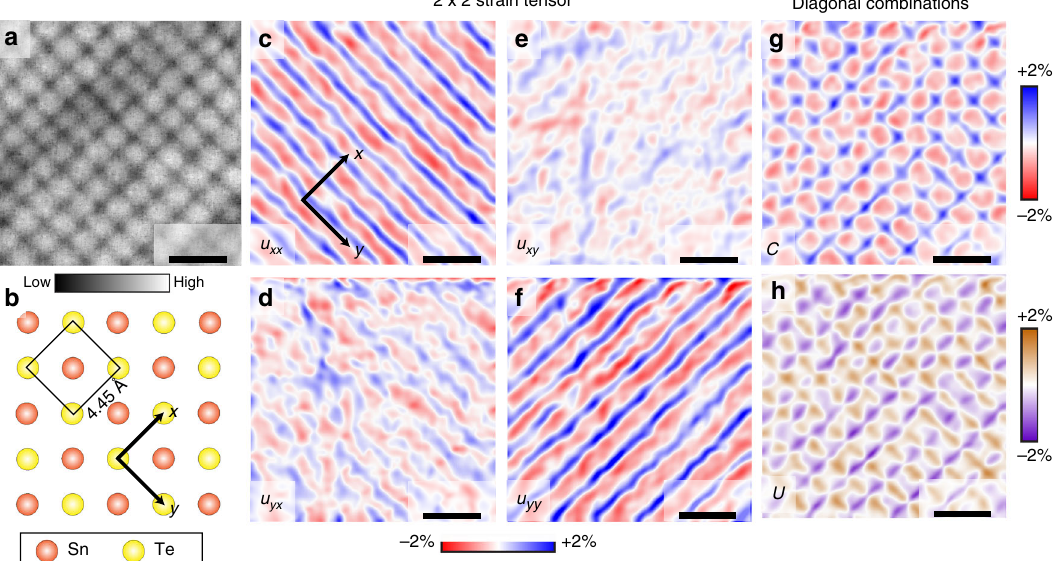
Fig. 2 Spatial distribution of different types of strain. a STM topograph of ~130 nm square region of the sample ( V set = − 50 mV, I set = 200 pA), showing the strain-generated topographic superlattice with period of ~ 15 nm. b Schematic of the (001) surface of SnTe. Arrows in b denote the x - and y -axes, which have the same orientation in all panels, as shown again in c . c-f The components of the 2 × 2 strain tensor ∇ u ( r ) extracted from the topograph in a . u ij denotes ( ∂ u i )/( ∂ r j ). g The biaxial strain map C . h The uniaxial strain map U . All scale bars are 30